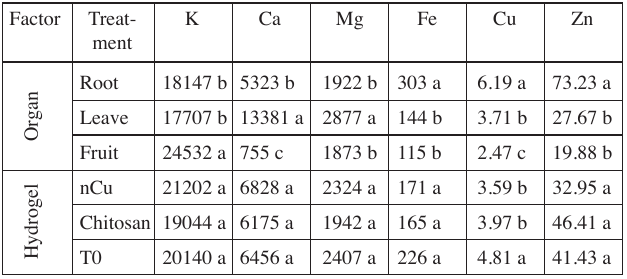
Tab. 3: Mineral concentration (μg g -1 [dry weight]) in tomato plants treated with nCu-chitosan hydrogel at a concentration of 0.006 mg nCu L -1